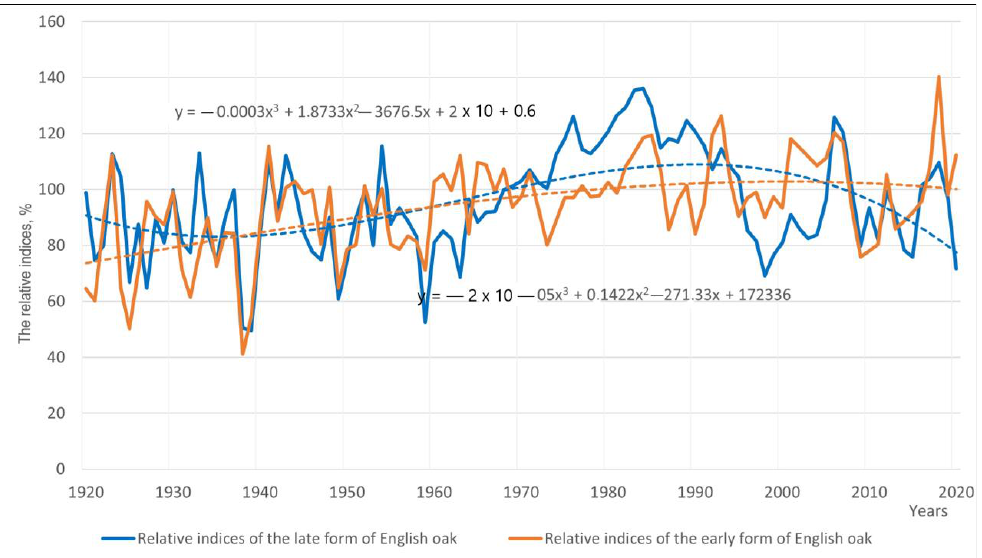
Figure 5. Long-term dynamics of relative indices of ARW in English oak in dry oak stand D1.